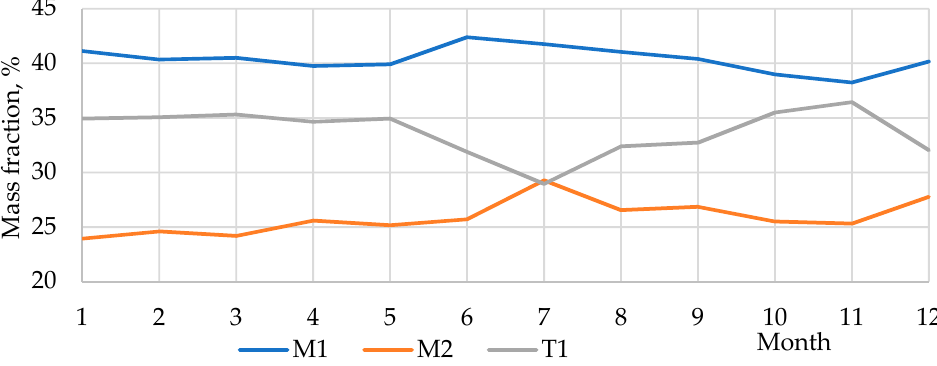
Figure 1. The composition of the processed charge by type of ore in 2019.